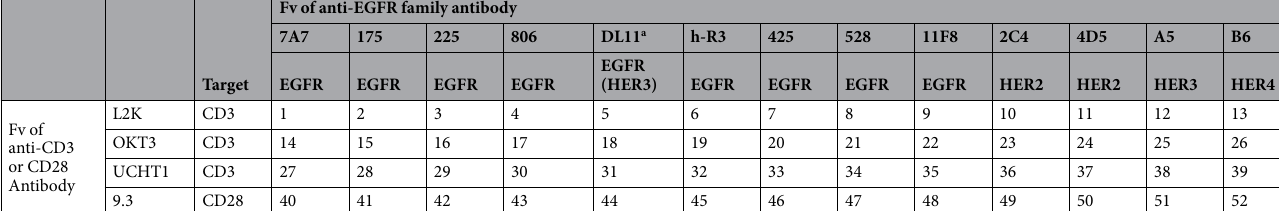
Table 2. Combination of the Fv fragments used to construct diabodies. Each diabody is labeled by the number listed in this table. a DL11 is an antibody against EGFR and HER3.